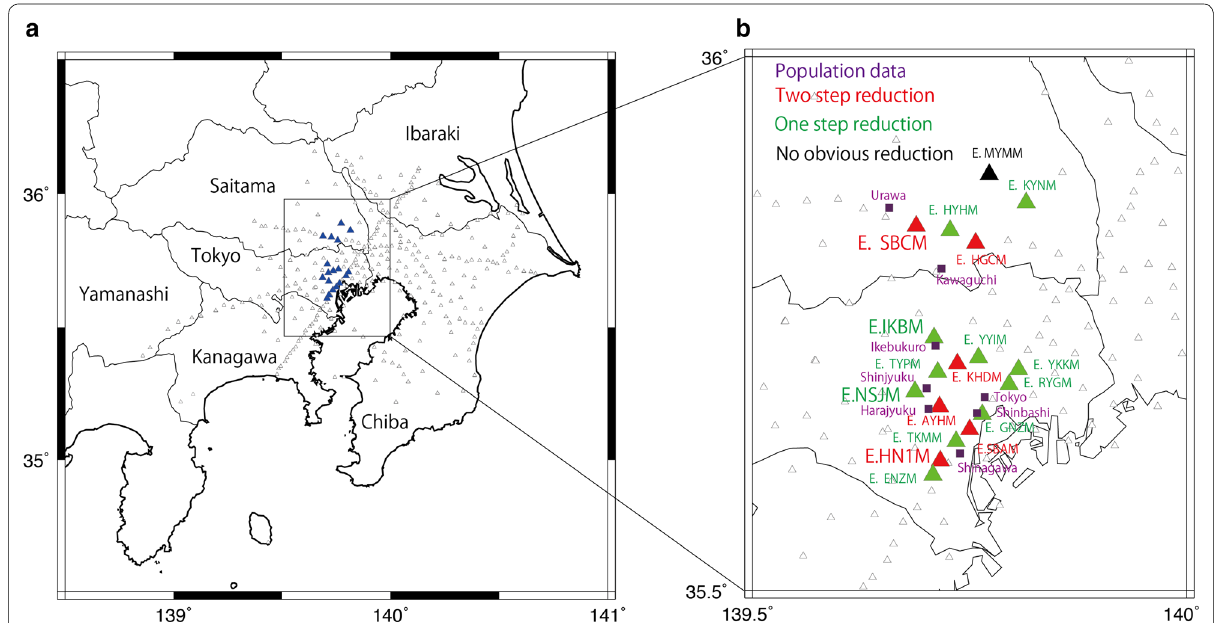
Fig. 1 Location map of stations in the MeSO-net in the Tokyo metropolitan area. a Map of Kanto region of Japan. Triangles show MeSO-net stations. Blue triangles are the MeSO-net stations considered in this study. b Close-up map in the middle of the Tokyo metropolitan area. Red, green, and black triangles show the type of noise reduction observed in this study. Purple squares are train stations for which population data are presented in Fig.